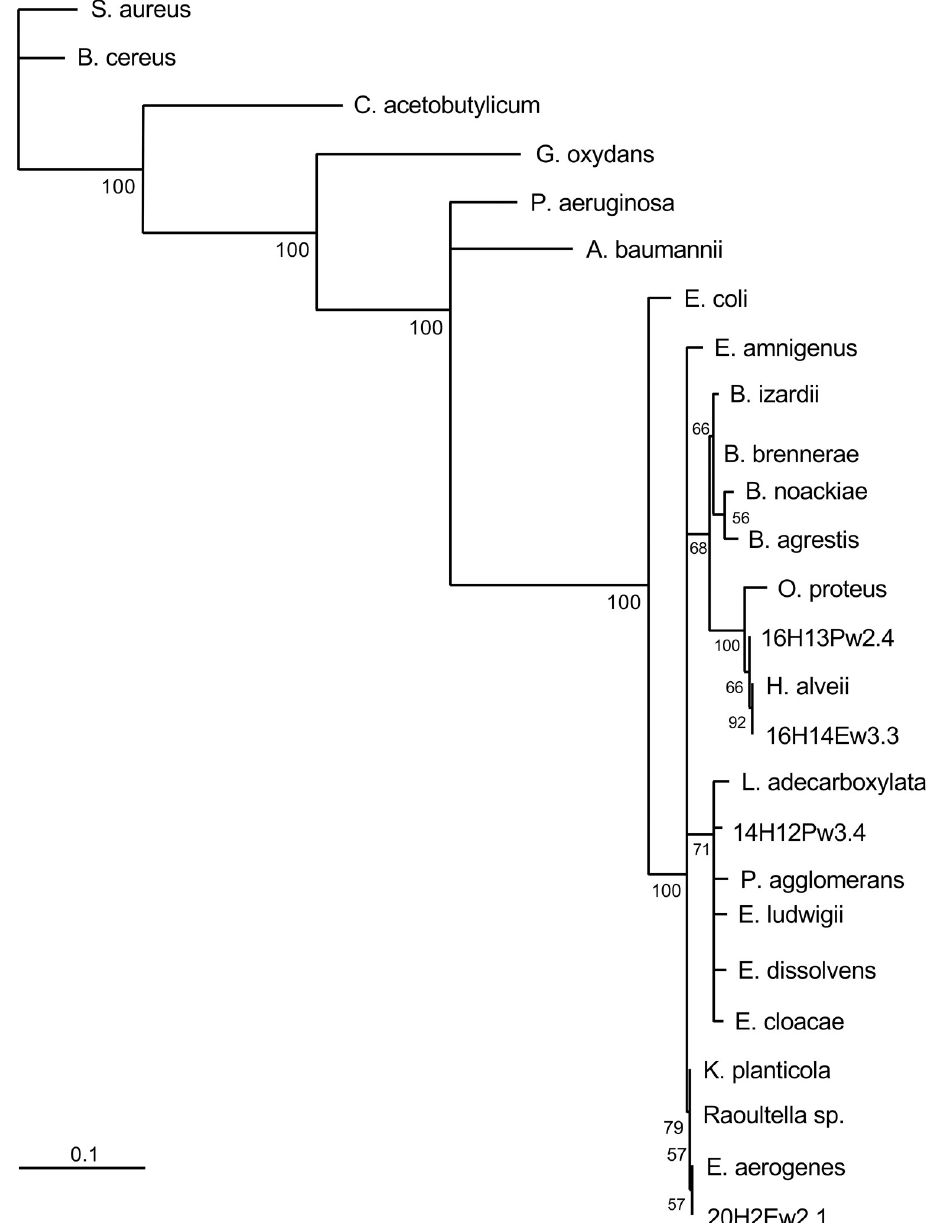
Fig 9. Phylogenetic analysis of 16S rRNA sequences (cluster II; enteric bacteria). Complementary DNA was amplified from aerobic bacteria isolated from the gut of nurse bees ( Apis millifera ) from Australia, sequenced, and sequences were aligned using the Fast Fourier Transform (MAFFT). A maximum likelihood phylogenetic tree was generated using PhyML3.0 and the general time reversible (GTR) evolutionary model. Bootstrap values detected for 100 replicates are shown near the nodes. The scale bar represents the change in nucleotides of the sequence (i.e., genetic variation for the length of scale).